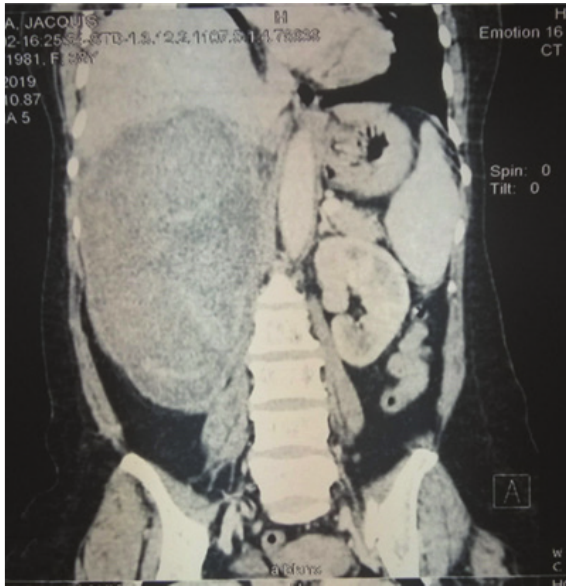
Figure 1: A contrast coronal CT-scan showing a hyper vascu- larized right T4 renal tumor found to have affected the renal vein, IVC, and inferior margin of the liver.